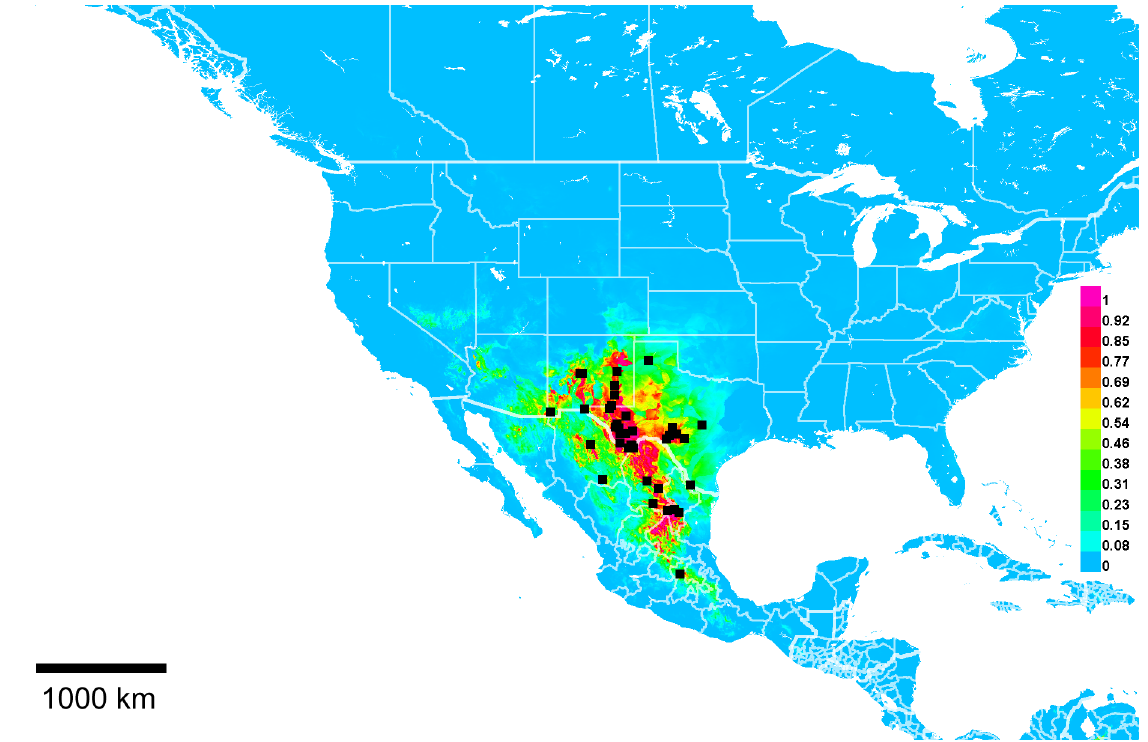
Fig. 50. Georeferenced collection records of Lasioglossum ( D .) profundum sp. nov. (black squares) and predicted distribution by maximum entropy ecological niche modelling in Maxent (colour shading). Warmer colours indicate higher cloglog probability of